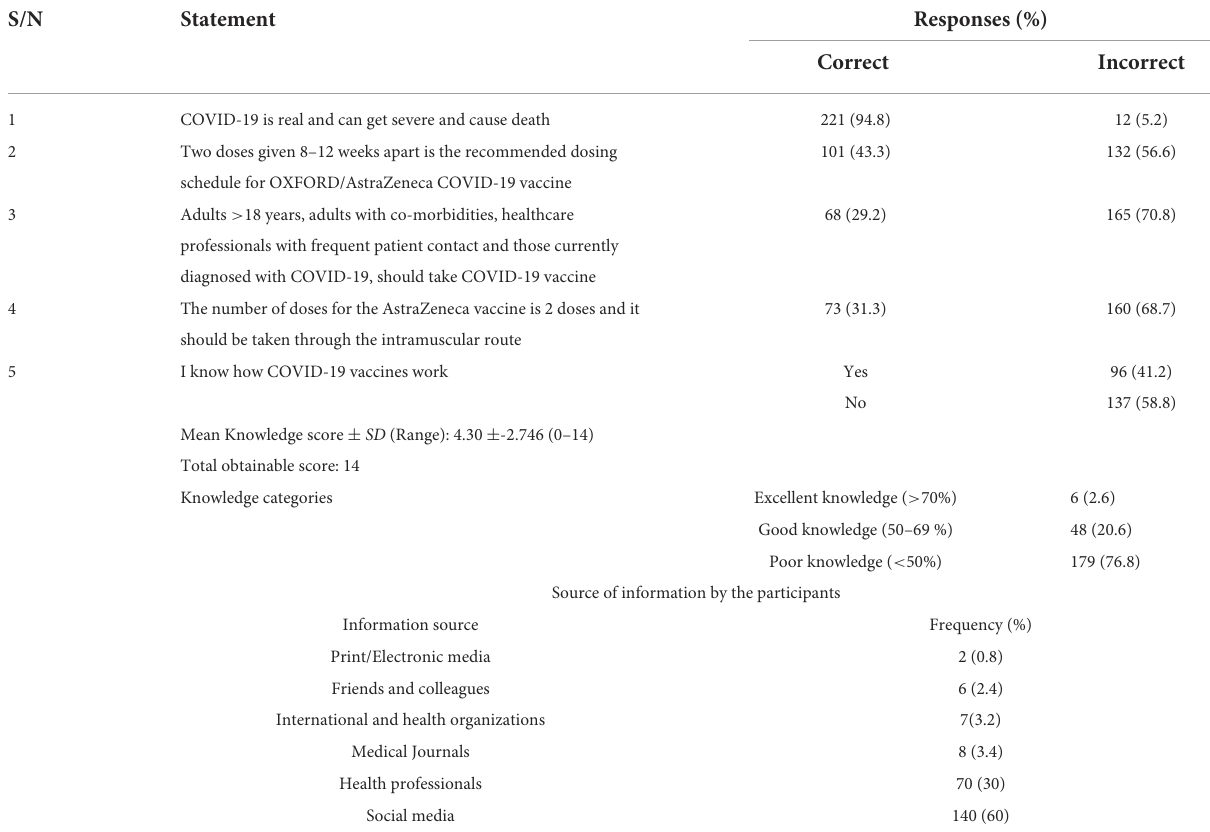
TABLE 2 Knowledge statements of study